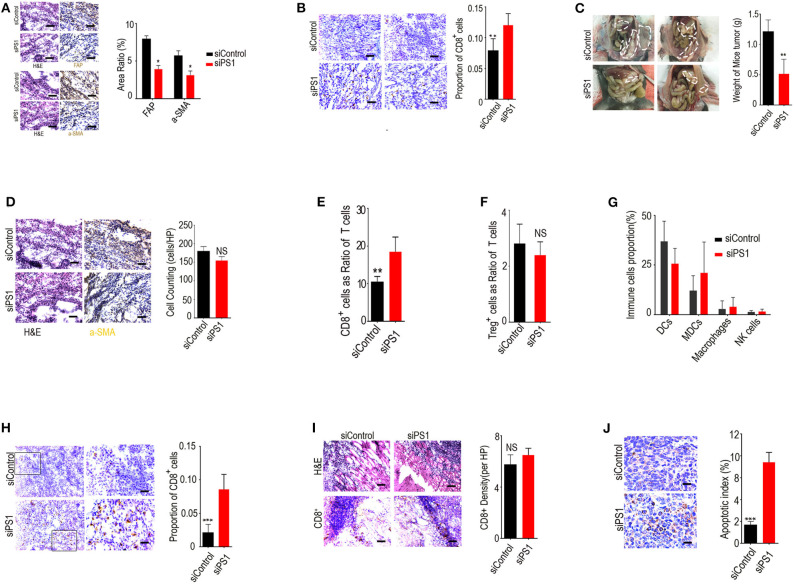
Silencing presenilin 1 (PS1) in ovarian tumors results in enhanced cytotoxic T lymphocyte (CTL) penetration and reduced tumor burden in vivo. (A) PS1, α-SMA, and FAP expression in the stromal compartment of the tumors after treatment with chitosan nanoparticles/PS1 siRNA. Results are representative of data generated in two independent experiments. *p < 0.05. (B) Tumor-infiltrating CD8+ CTLs after treatment with chitosan nanoparticles/PS1 in C57B/6 mice bearing orthotopic ID8 ovarian tumors. The result is from one of three similar experiments (n = 3). (C) Tumor burden in mice after 3 weeks treated with chitosan nanoparticles/PS1 small interfering RNA (siRNA). (D) Cancer-associated fibroblast (CAF) counts in juxtatumoral tissues by HE staining after siRNA treatment (n = 3). (E–G) The number of CD8+ T cells, dendritic cells, myeloid-derived suppressor cells, nature killer cells, and macrophages in tumors compared to the controls, checked by flow cytometry (n = 3). (H) CD8+ T cell density in the tumor parenchyma by immunohistochemistry after treatment with PS1 siRNA (n = 3). (I) CD8+ T-cell density in the in the tumor stroma by immunohistochemistry after treatment with PS1 siRNA. (J) Caspase-3 expression in the tumor parenchyma densely infiltrated by CD8+ T cells than in areas sparsely infiltrated by CD8+ T cells in PS1 siRNA-treated mouse tumors. The result is from one of three similar experiments (n = 3) (A/B/D/H/I/J scale bar = 50 μm). **P < 0.01 and ***P < 0.005.